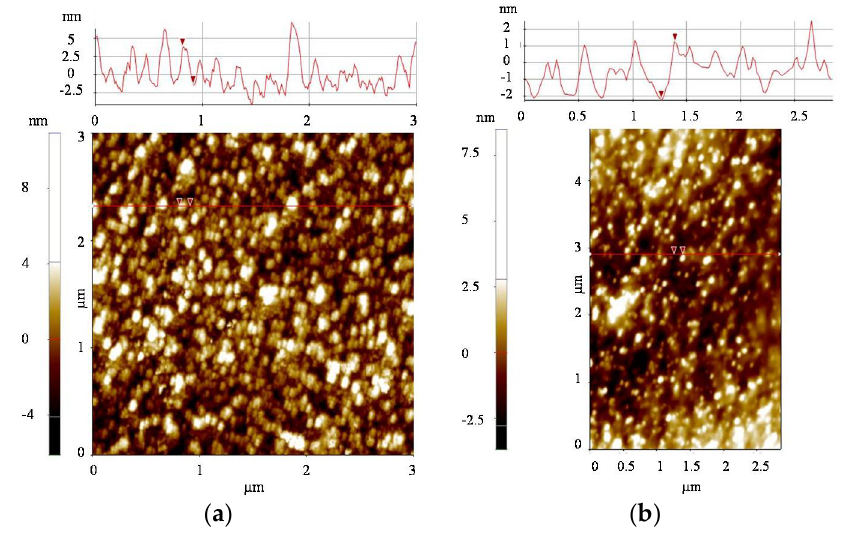
Figure 11. AFM images of ITO/PEN sheet: ( a ) as-received; ( b ) after tensile bending with a 10 mm curvature radius for 1000 h.